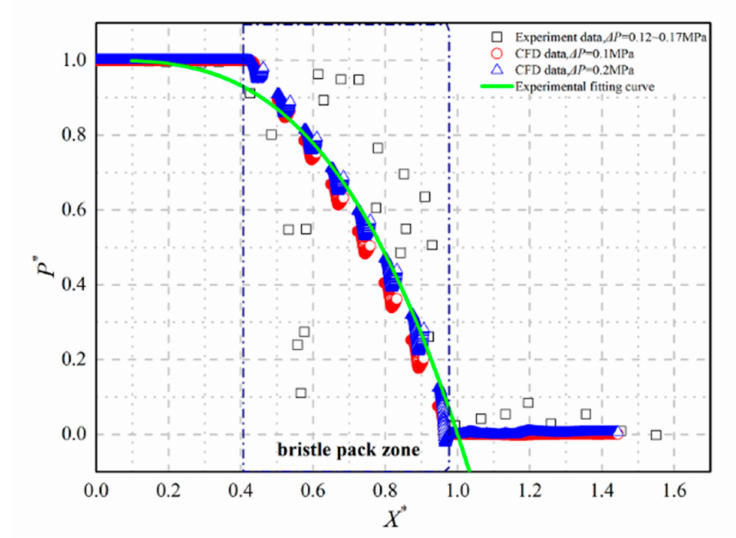
Figure 3. Comparison of the predicted and Bayley and Long’s pressure distributions